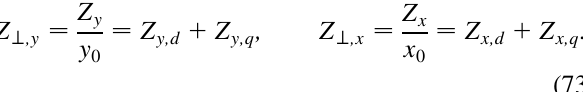
FIG. 5. Plot of functions G